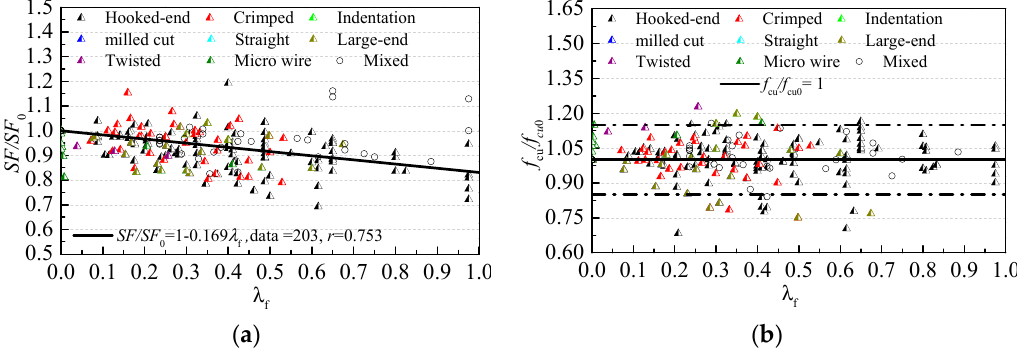
Figure 7. The influences of steel fiber on the fresh and hardened performances of SC-SFRC: ( a ) variation of slump flow ratio SF/SF 0 with fiber factor λ f ; and ( b ) variation of cubic compressive strength ratio f cu / f cu0 with fiber factor λ f .